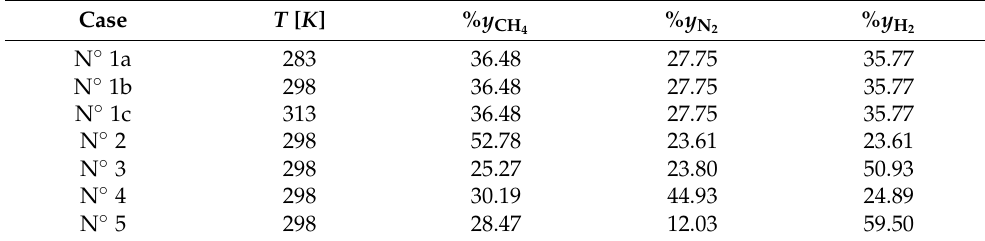
Table 1. Experimental conditions: temperature and gas